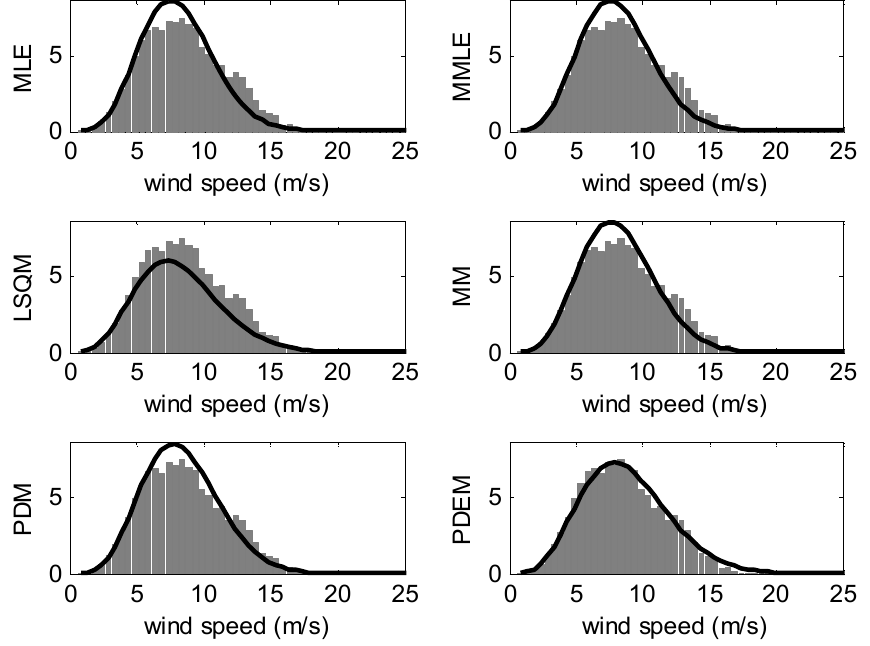
Figure 8. Distribution of the wind power density derived from the estimated Weibull PDF compared with that derived from the wind speed data (bar diagram) at wind site n° 21 (O